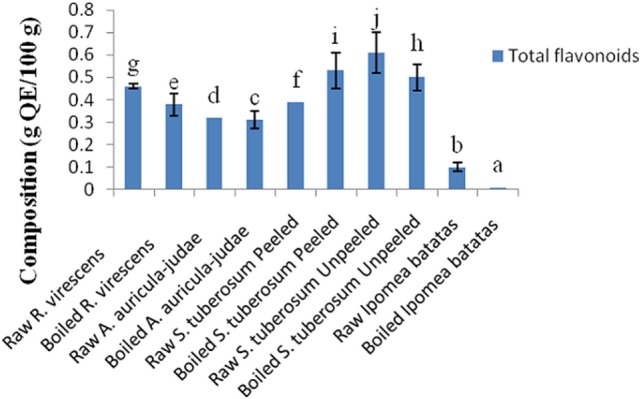
Total flavonoid contents of aqueous extracts of raw and boiled mushrooms, potato, and sweet potato. Values are reported as means ± SD. (a–j) Means with different superscripts are significantly different (P < 0.05) across the groups. QE, quercetin equivalence.